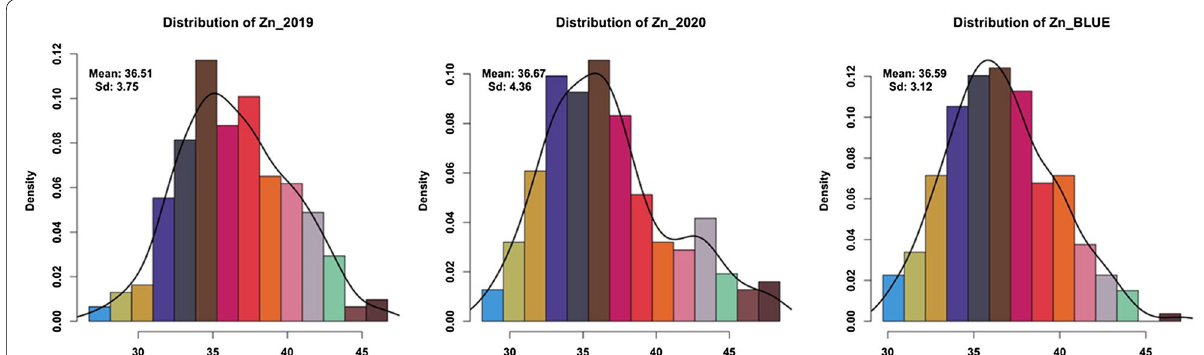
Fig. 2 Distribution of phenotypic data in all genotypes for Zn concentration for each year (2019/2020) and BLUEs in spring barley